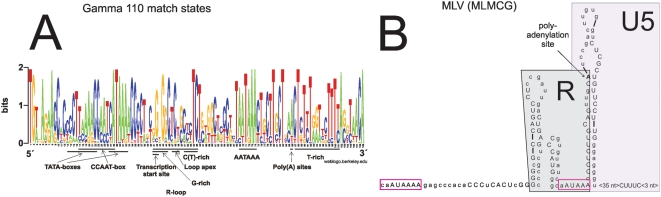
Outcome of the gamma HMM.A. Weblogo for a Viterbi alignment of the gamma training set (“gamma”). Conventions are as in Fig 1. B. MLV RU5 (MLMCG) RNA analysed with the gamma HMM and MFOLD. Match state positions are in upper case. R boundaries [43], [56], [57], [58], TATA box and AATAAA are shown. A partially conserved predicted stem loop early in R [31] is also shown.